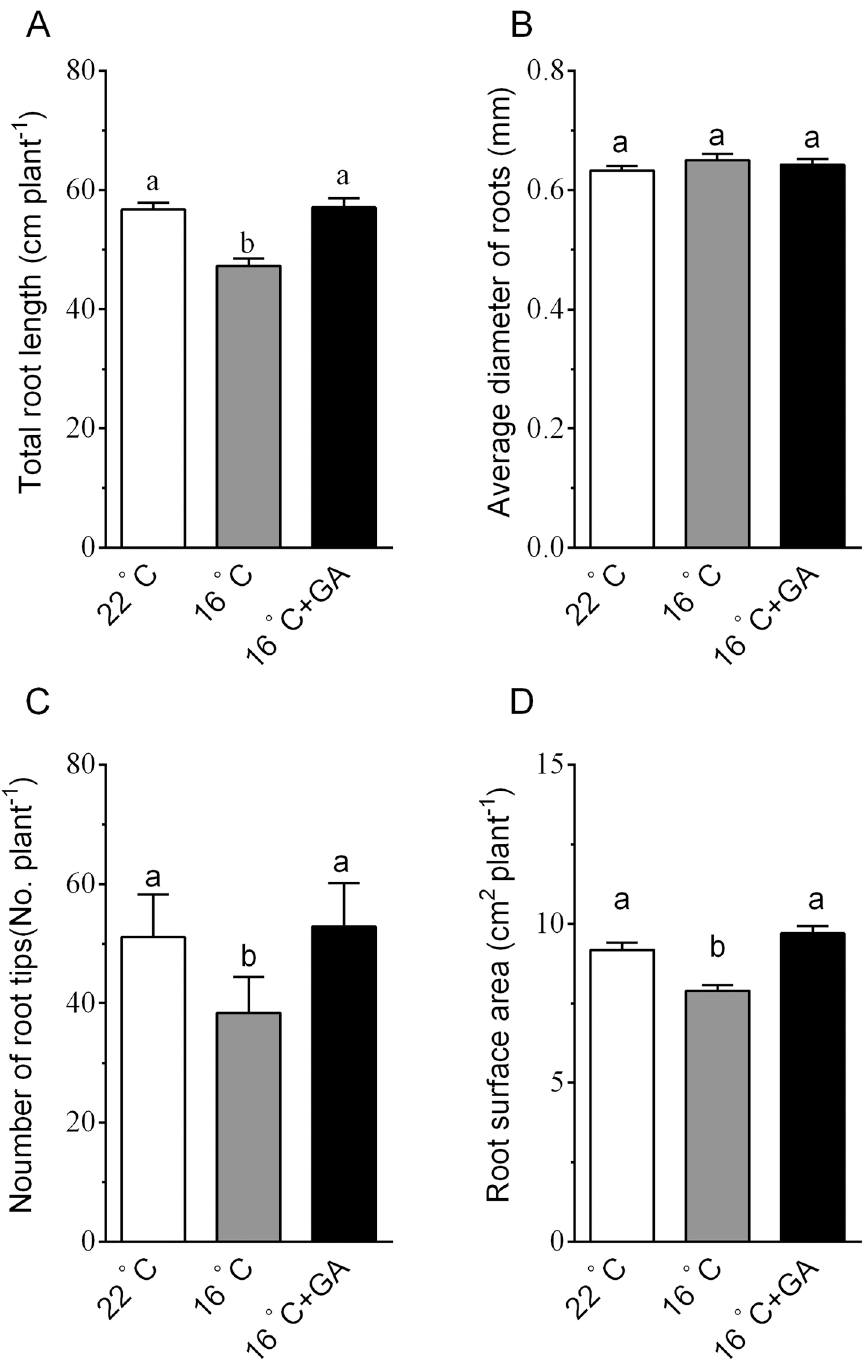
Fig 2. Effects of suboptimal T r and GA on root morphological parameters of cucumber seedlings. (A) Total root length of cucumber seedlings. (B) Average diameter of roots of cucumber seedlings. (C) Number of root tips of cucumber seedlings. (D) Root surface area of cucumber seedlings. 10-day-old seedlings were transferred to 16°C T r conditions in the presence or absence of exogenous 5 μ M GA for 5 d. Data are means ± se. Different letters on the top of column indicate significant differences ( P < 0 . 05 , n = 6).